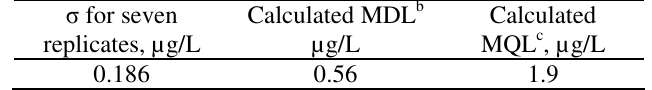
Table 5. Method detection and quntification limits for bromate a σ for seven Calculated MDL b replicates, µg/L